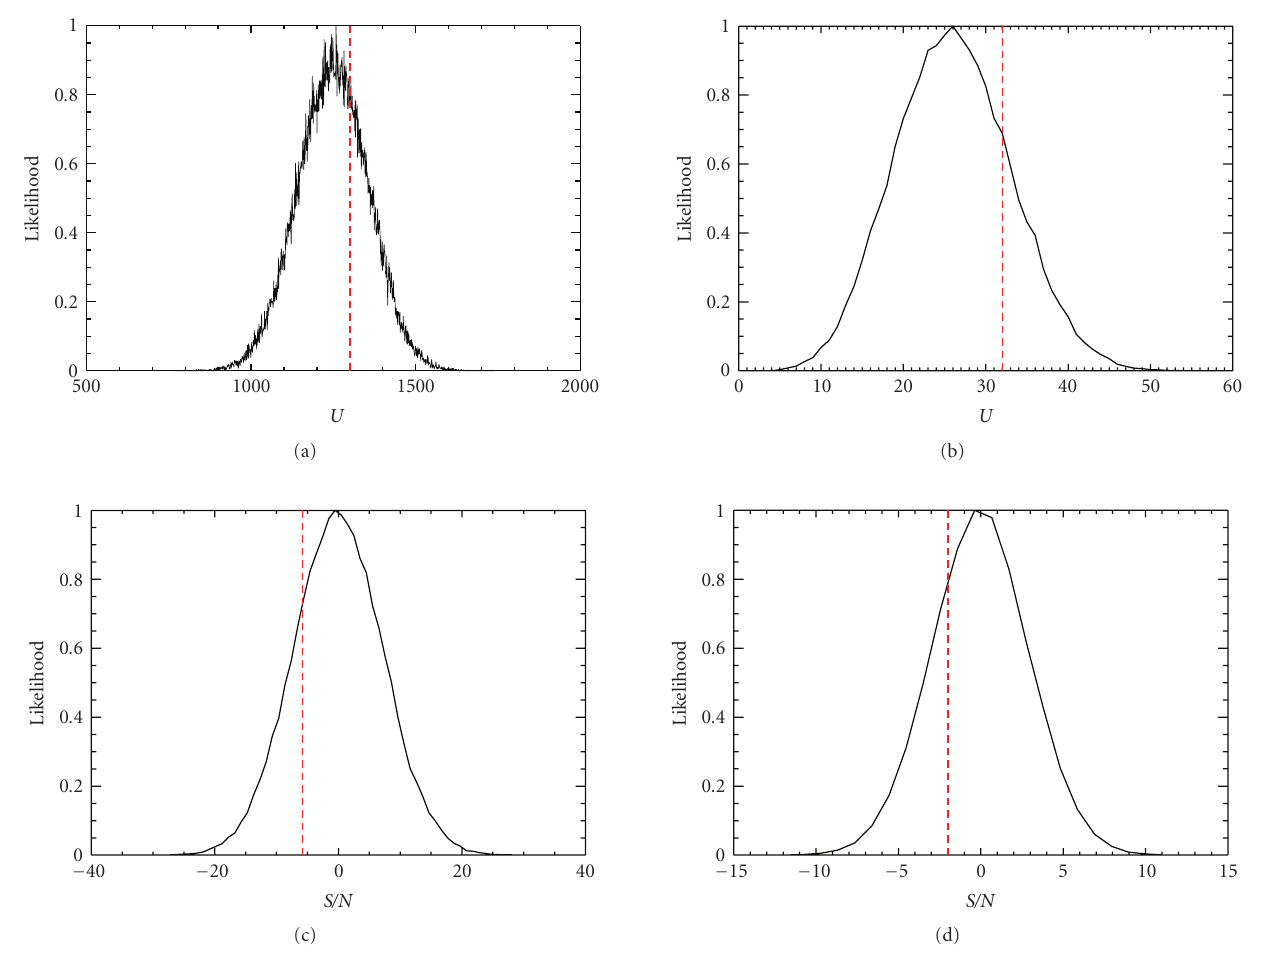
Figure 4: The upper left plot shows the results for the Wilcoxon rank sum test using the unbinned data. The dashed red line shows the mean value of U if r = 0. The solid black line is the distribution of U with the WMAP5 dataset and a mock dataset with WMAP5 error bars and r = 0. The upper right plot is the same as the upper left plot except it uses the binned data. The lower left plot shows the results for the S/N test using the unbinned data. The dashed red line is the value of S/N for WMAP5. The solid black line is the distribution of the S/N value for a mock dataset with r = 0 and WMAP5 error bars. The lower right plot is the same as the lower left plot except it uses the binned data. Table 1: A table of the zero multipole, (cid:2) 0 , and the uncertainty in (cid:2) 0 , Δ (cid:2) 0 , for the di ff erent fitting routines and datasets considered